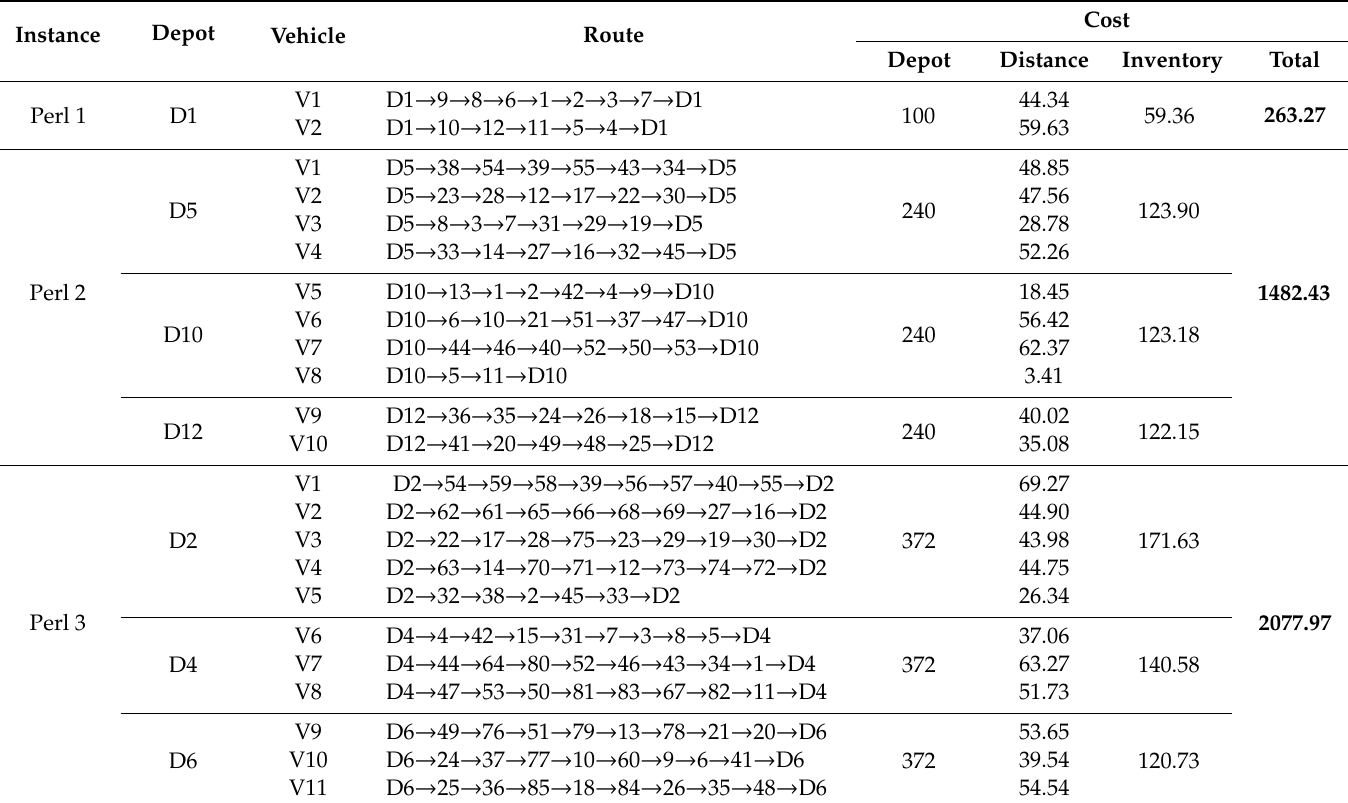
Table 9. Distribution of routes and costs for Perl dataset generated by HS-SA for